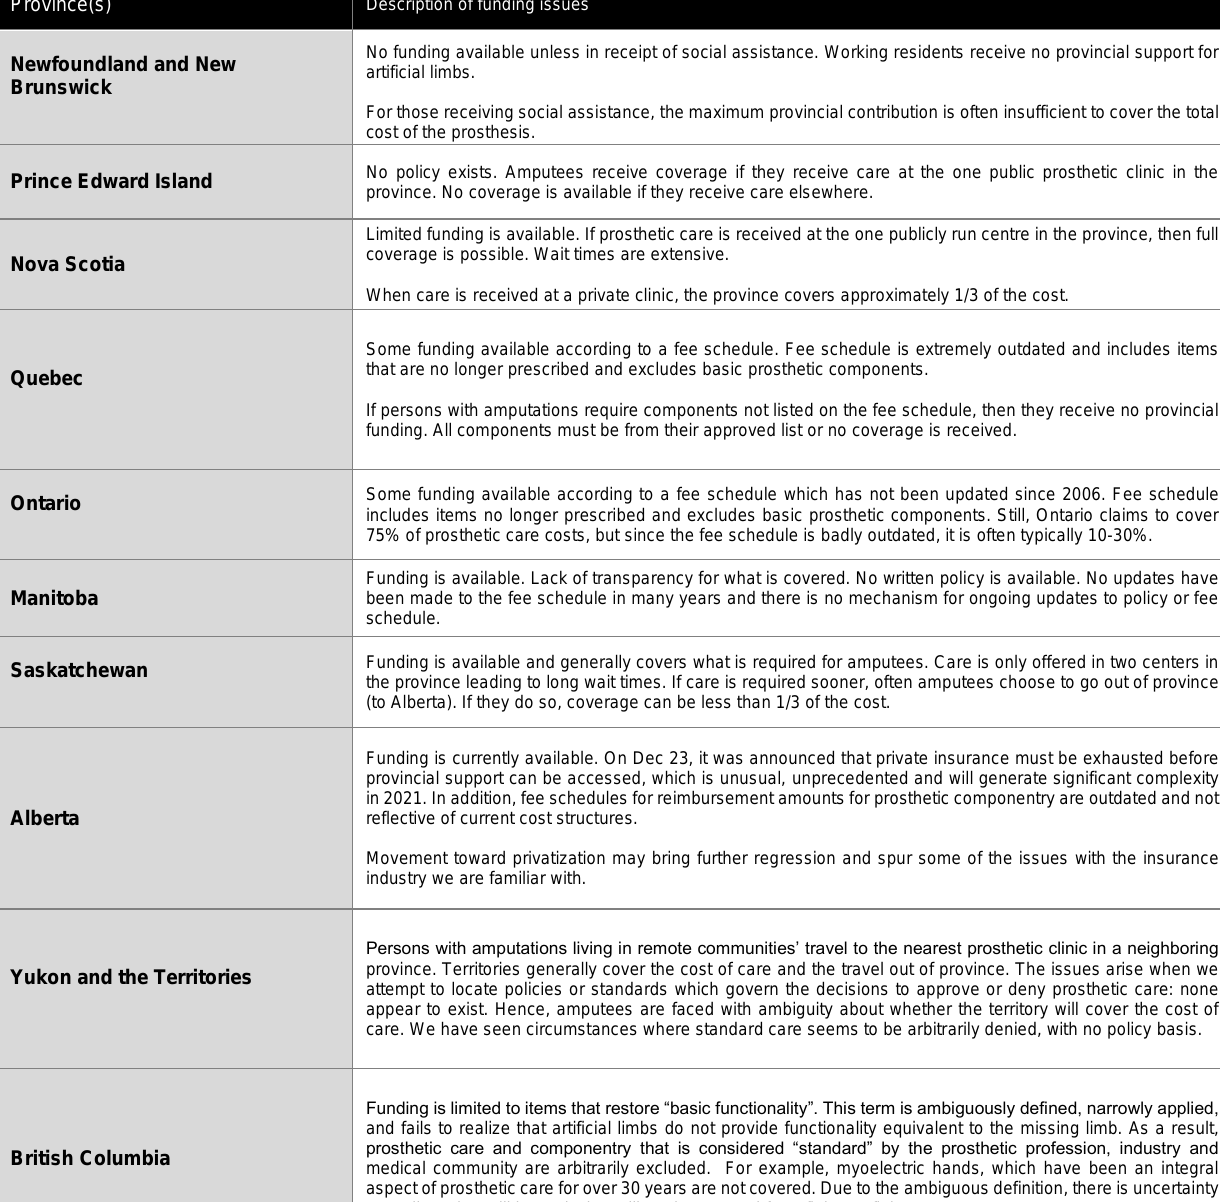
Table 1 : Provincial Funding Issues.